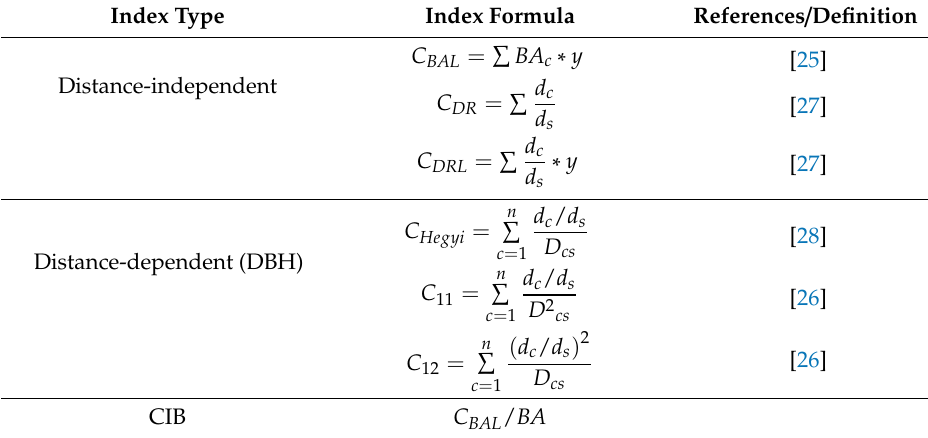
Table A1. Competition indices types and